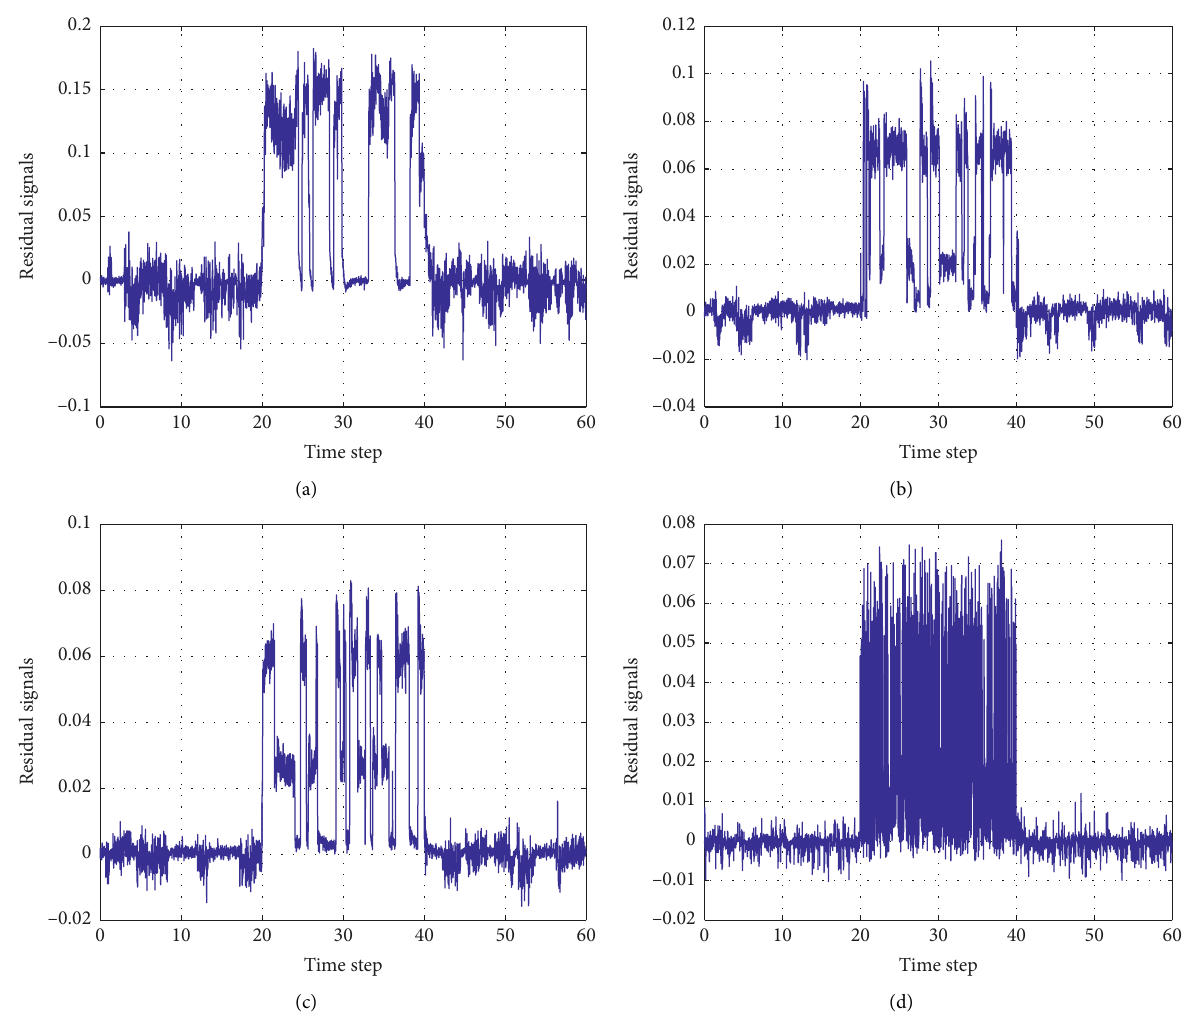
Figure 3: Residual generation of reduced-order FDF for four different TRMs cases. (a) Case 1. TRM is completely known. (b) Case 1. TRM is polytopic uncertain. (c) TRM is partly unknown. (d) TRM is completely